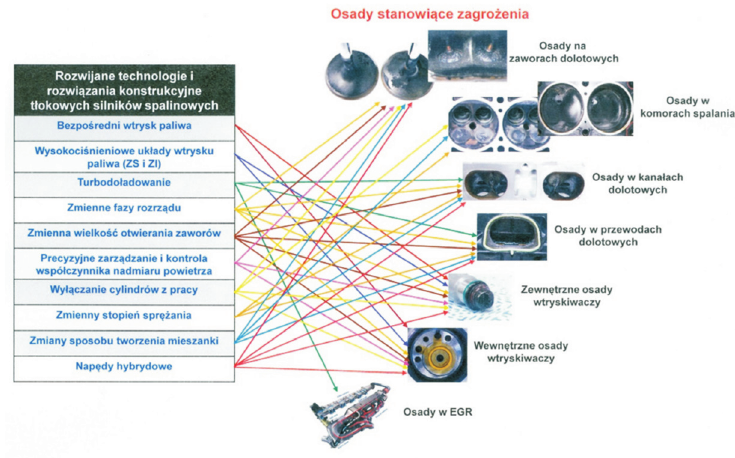
Fig. 1. The influence of various technologies and design solutions of piston engines on the formation of deposits hazardous to all engine components Rys. 1. Wpływ różnych technologii i rozwiązań konstrukcyjnych tłokowych silników spali - nowych na tworzenie osadów stanowiących zagrożenia dla poprawnego